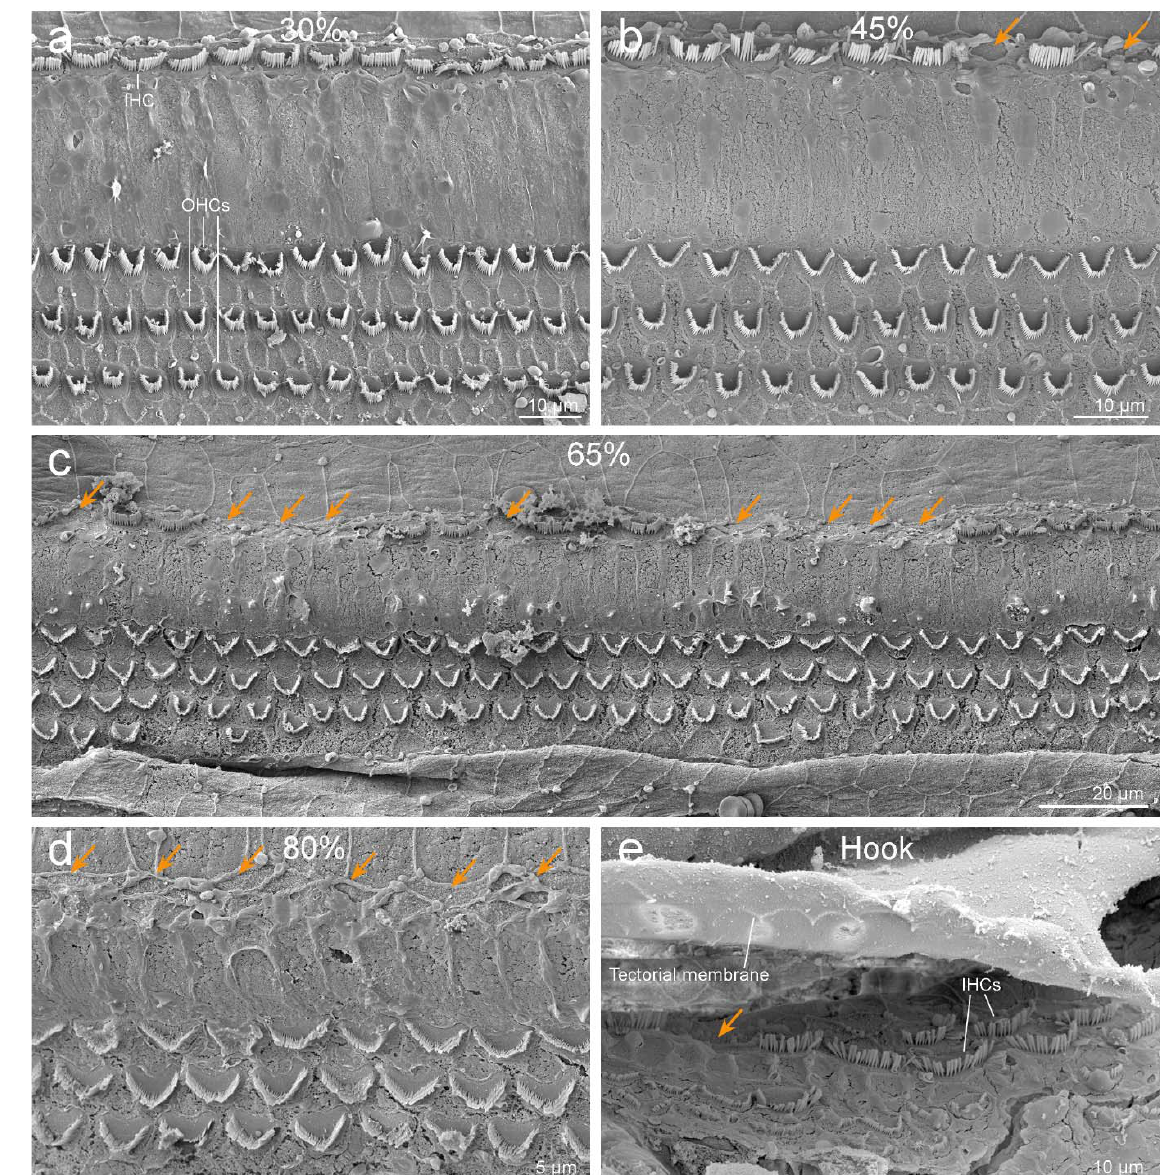
Figure 2. Scanning electron microscopy images of the organ of Corti of the left ear along the cochlear spiral, at 30% ( a ), 45% ( b ), 65% ( c ), and 80% ( d ) distances from the apex. Note that while the outer hair cells (OHCs) are present forming three (and sometimes four) rows, there is a loss of inner hair cells (IHCs, highlighted with orange arrows), with increasing severity towards the base. ( e ) First IHCs of the hook. The three first IHCs are arranged in two rows. The undersurface of the tectorial membrane shows the imprints where the stereocilia of OHCs are inserted.